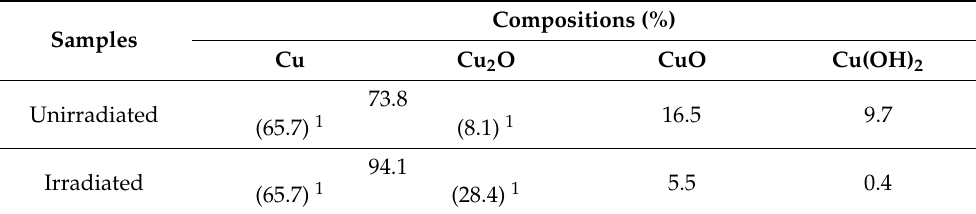
Table 1. Compositions of Cu, Cu2O, CuO and Cu(OH) 2 determined by Cu 2p 3/2 photoemission spectra (PS) lines for the unirradiated and irradiated